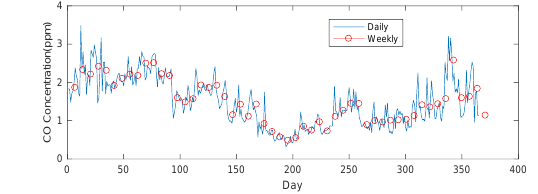
Figure 3. Daily and weekly measured surface CO concentrations [ppm], averaged over the 9 ground stations in Wuxi, China, for the entire year of 2013. Data can be found at